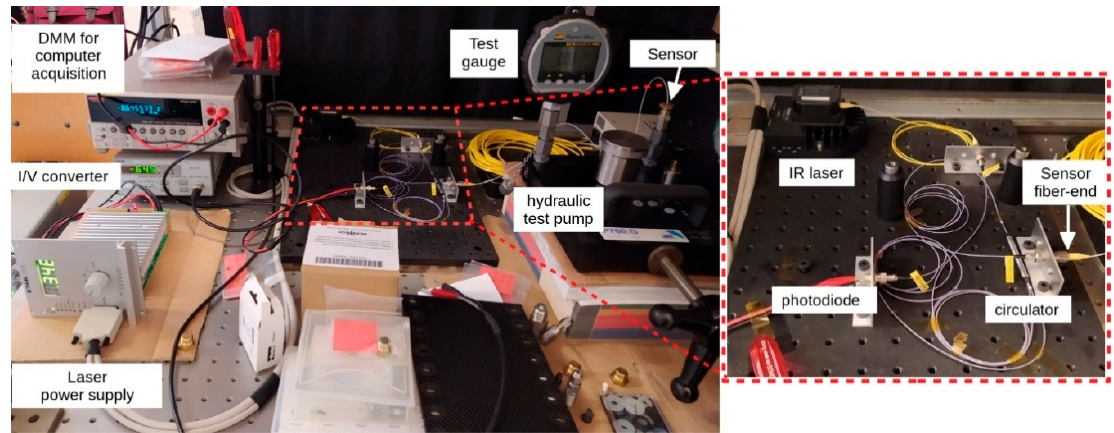
Figure 6. Picture of the measurement set-up used for S-SiC sensors characterizations at different values of inlet static pressure. On the right, a detail of the optoelectronic system used for interference signal measurement (see ref. [39] for more details).